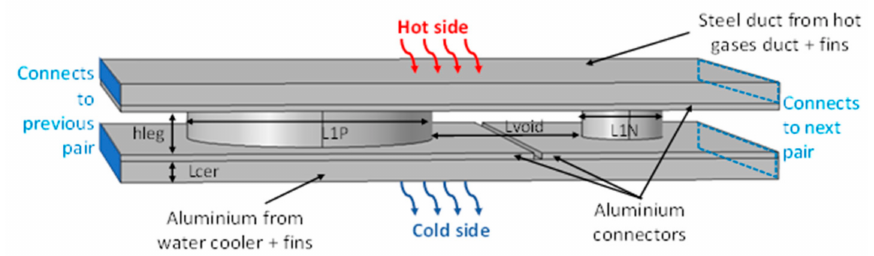
Figure 6. Geometry used in the custom module